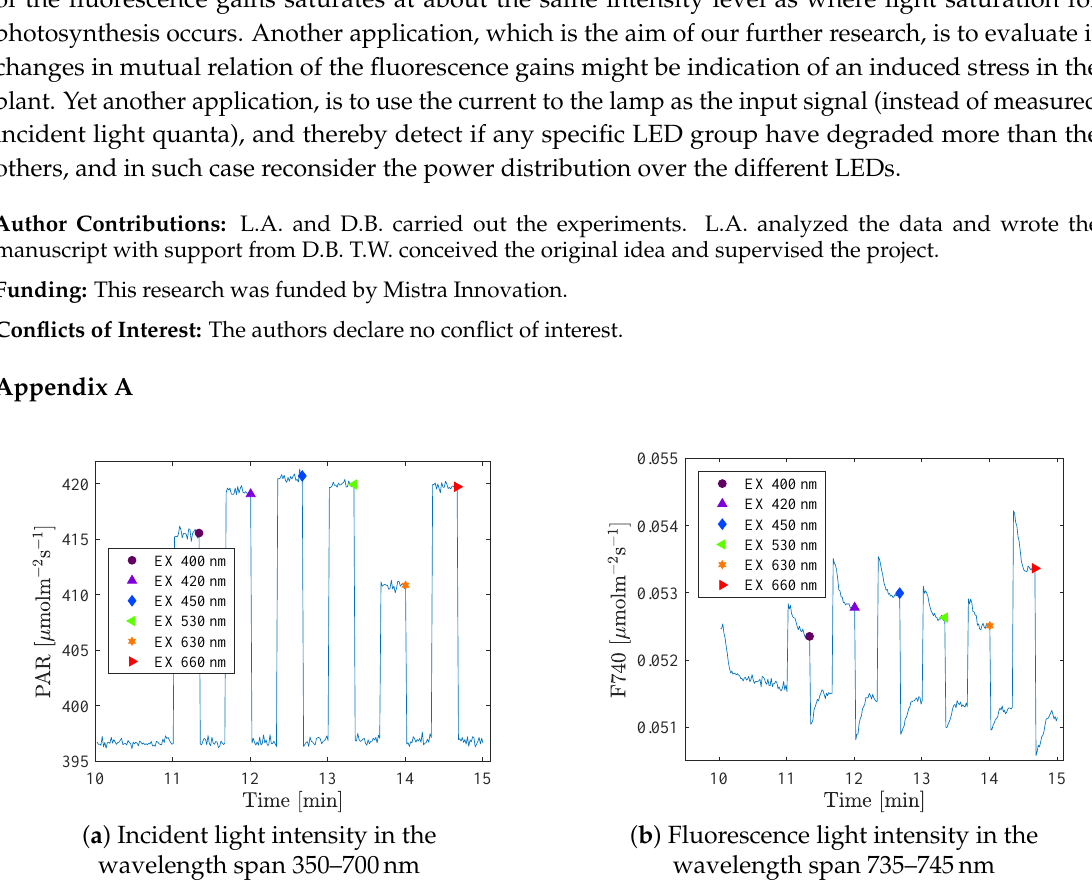
Figure A1. Measurements on lettuce, holding each intensity level at 20 s. ( a ) Incident and ( b ) fluorescence light intensity (µmolm − 2 s − 1 ) vs. time for one background light level, i.e., background intensity 500µmolm − 2 s − 1 and spectrum having 85% red light. An excitation step is sequentially added by each LED colour. Note that the intensity level measured during the experiment was only about 397 and not 500µmolm − 2 s − 1 . This is because when the light level was determined, no plants were present in the experimental unit and another type of spectrometer was